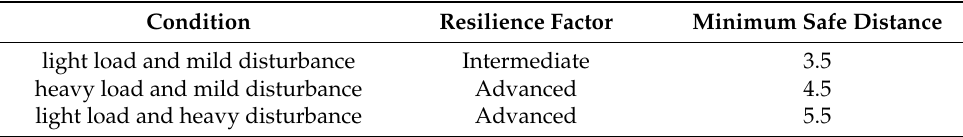
Table 4. Comparison of minimum safe distance under different disturbance scenarios.